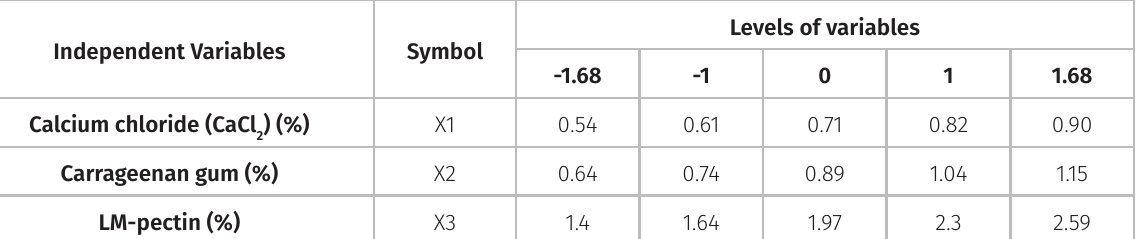
Levels of variables -1.68